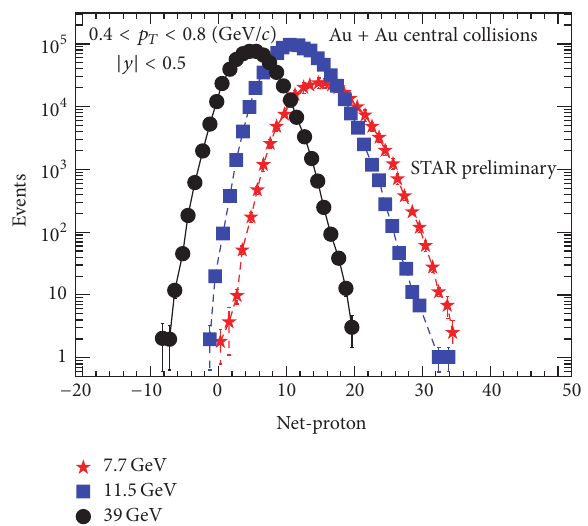
Figure 6: Uncorrected Δ𝑁 𝑝 multiplicity distributions measured on an event-by-event basis in Au + Au collisions at various √𝑠 𝑁𝑁 for 0–5% collision centrality measured by STAR